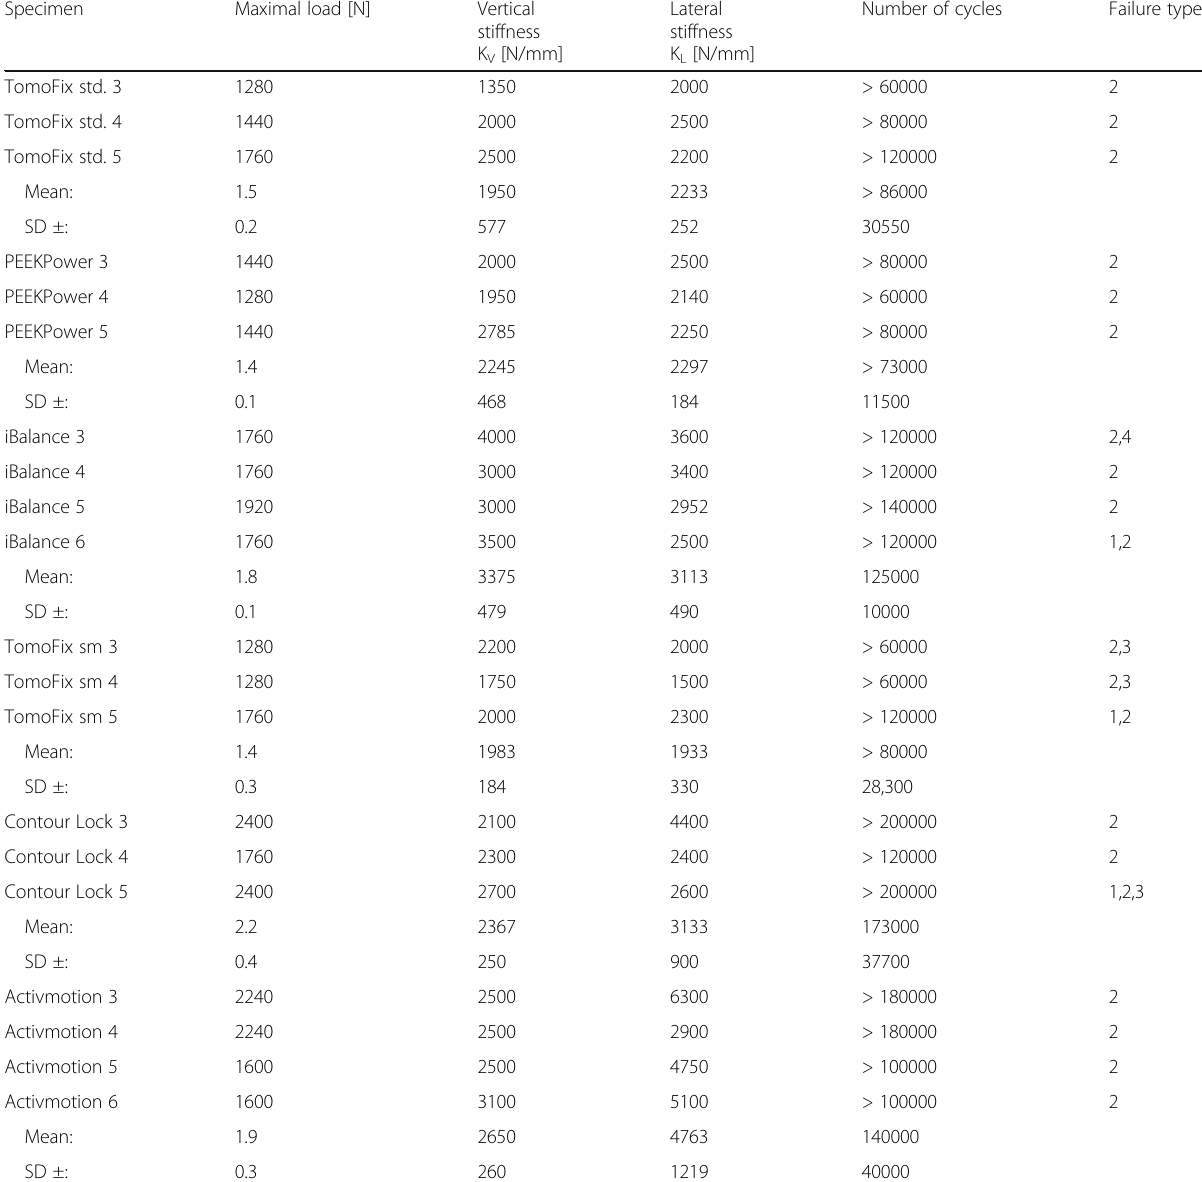
Table 6 Summary of fatigue failure tests: maximal load, vertical & lateral stiffness, number of cycles (all values prior to failure) and failure types. The values of the first 5 groups have been retrieved from our previous studies and reported here for comparison purposes. All the differences were not statistically significant